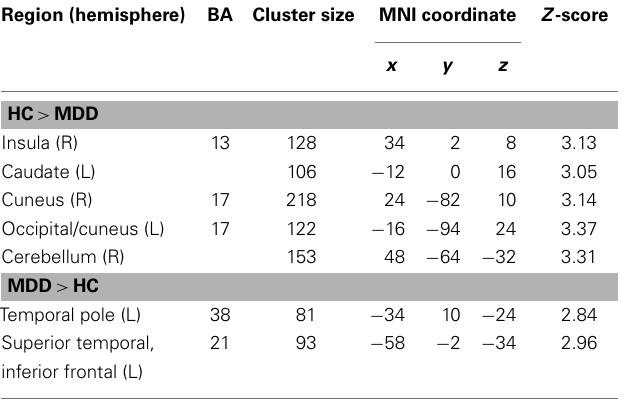
Table 3 | Brain regions exhibiting a significant difference between patients with MDD and HC in the resting-state functional connectivity of the right amygdala ( p < 0.05, corrected for multiple comparisons).